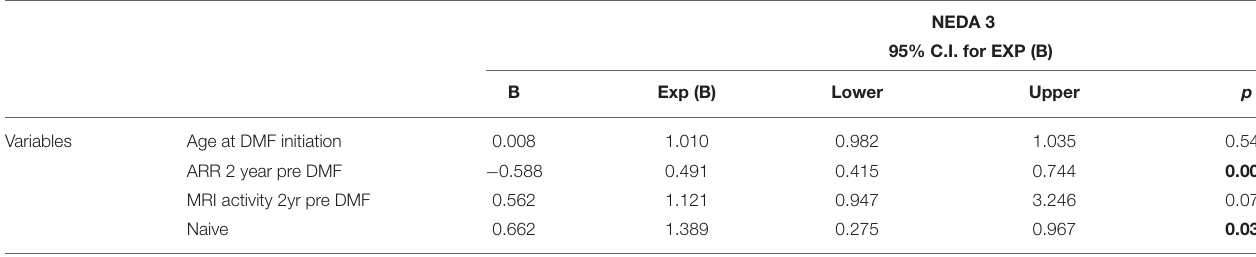
TABLE 4 | NEDA 3. Predictors of therapeutic response in patients exposed to 24 months of dymetilfumarate.